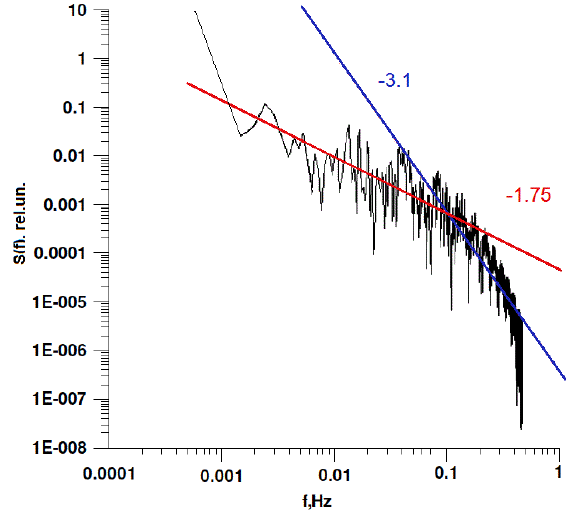
Fig. 8. An example of the EF spectrum, generated by the flow of electric charges (probe sources) distributed over the layer of 100 m in